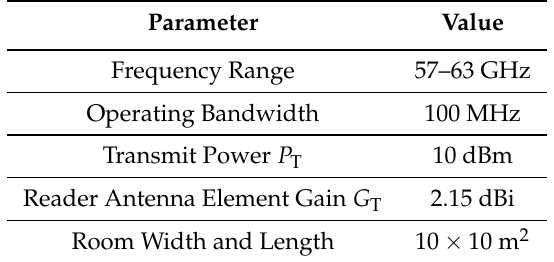
Table 1. Large-scale MIMO-based RFID localization system